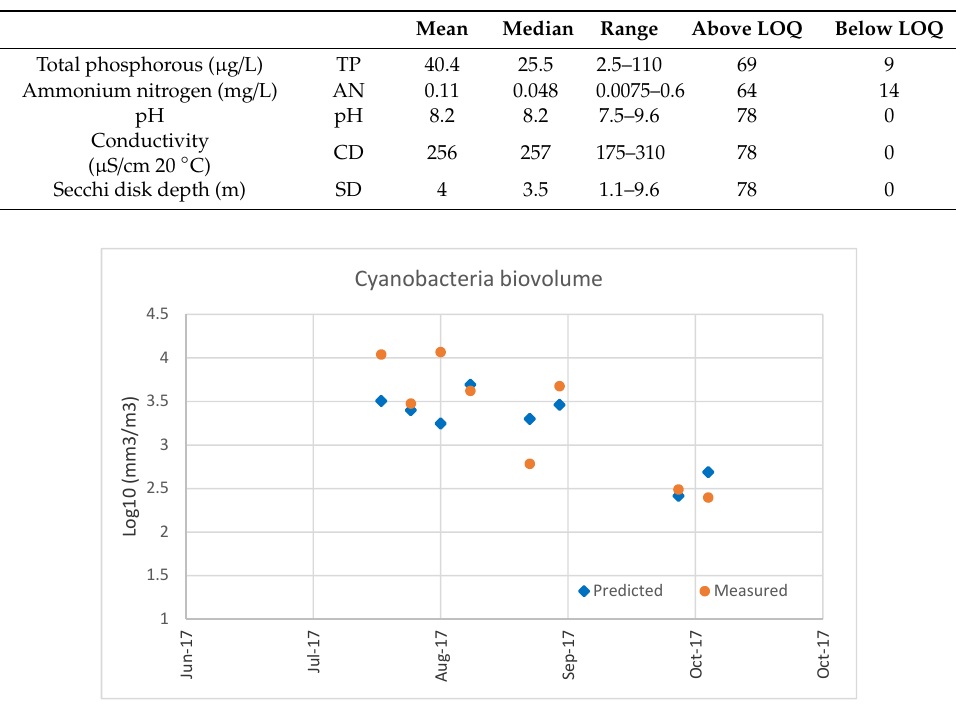
Figure A4. Validation of model No.2 in Table 1: Measured and predicted cyanobacteria biovolumes at Lake Varese using an independent dataset (not included in the MLR analysis) of water samples collected at Lake Varese during summer 2017. The T14 was calculated using forecasted temperatures at Lake Varese by the Global Forecast System (GFS) of the National Centers for Environmental Prediction (NCEP, http://www.emc.ncep.noaa.gov/). Table A4. Three-variable multiple linear regression (MLR) models of cyanobacteria biovolume (LOG CyanoBV) using the 14-days mean atmospheric temperature (T14) and two of the physical–chemical variables (AN: Ammonium nitrogen; CD: Conductivity; TP: Total phosphorous; SD: Secchi disk depth; and pH). The statistical significance of each coefficient is indicated when below 0.1 ( p -values: ***: 0.001; **: 0.01; *: 0.05; °, 0.1). For each model the coefficient of determination (R 2 ), the adjusted R 2 (R 2 adj), and the F statistic are reported. LOG means 10-based logarithm. No.